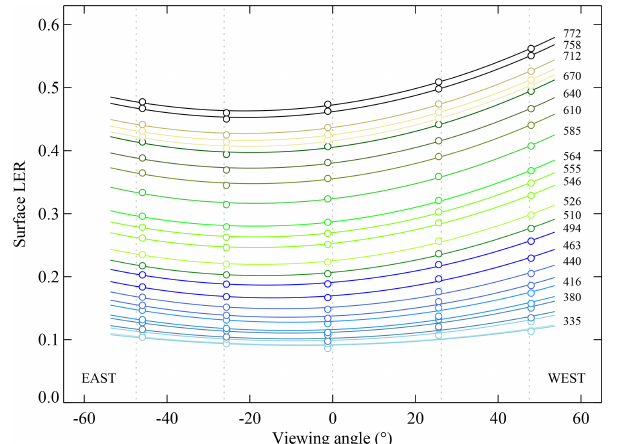
Figure 2. Surface LER retrieved for a grid cell over the Sahara desert for the five viewing angle containers (indicated by the cir- cles). The associated viewing angle θ v is plotted on the horizontal axis. The vertical dotted lines indicate the centres of the viewing angle ranges. Colours indicate the selected wavelength bands. The curves are parabolic fits through the data